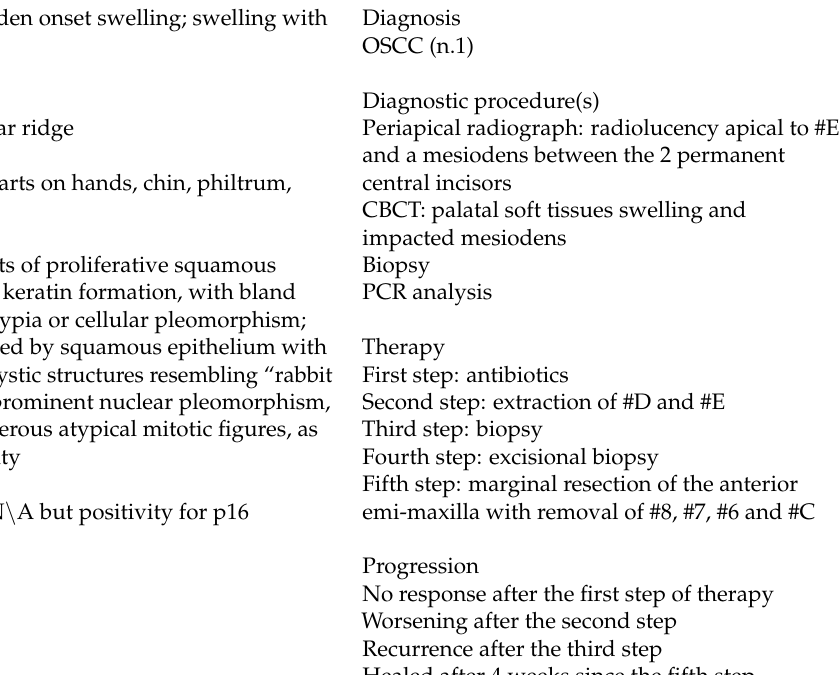
Table 3. Extracted and collected data from studies reporting pediatric cases diagnosed with oral squamous cell carcinoma. Study characteristics: first author, year, and journal of publication; study design; the reference number; funding. Study methods: sample size (n.), mean age (y.o.), gender ratio (M/F), country, comorbidities and associated ongoing treatments, relatives with similar lesions, HPV exposure (if any), time to onset of oral lesions, type of HPV vaccine administered (if any). Oral HPV-related lesions: macroscopic and microscopic features, number (single/multiple), distribution (unilateral/bilateral, asymmetric or symmetric), location, extra-oral involvement, HPV genotype. Diagnosis: definitive diagnosis, diagnostic procedure(s) performed, therapy, progression. Lee,